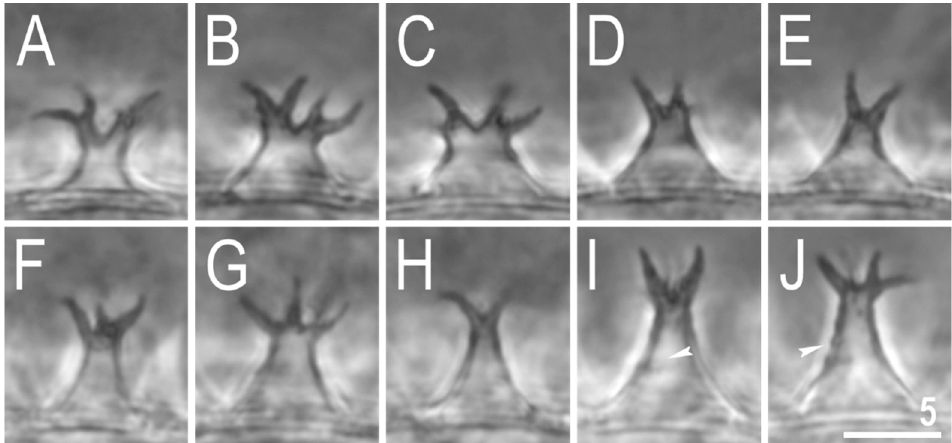
Figure 10. Mesobiotus marmoreus sp. nov. —PCM images of the egg processes midsections under ×1000 magnification. Filled indented arrowheads indicate faint thickenings and darkening that in SEM are visible as annulations (see Figure 11). Scale bar in μ m.